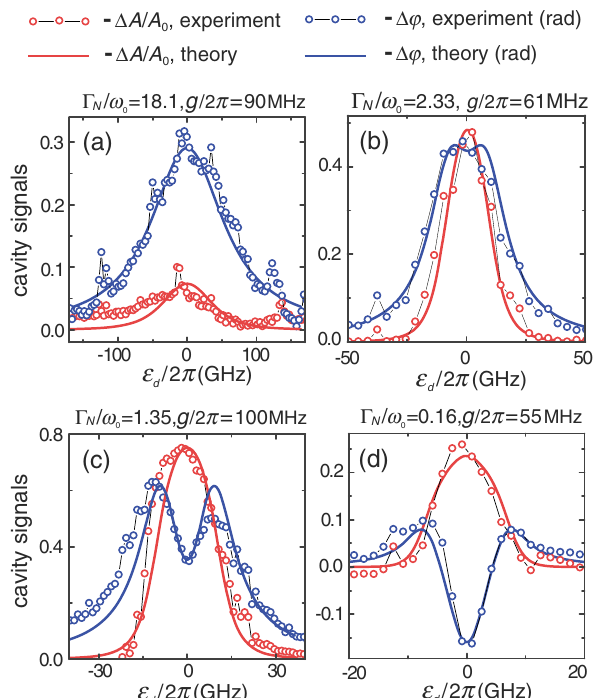
FIG. 2. Panels (a – d): Measured phase shift Δ φ (blue dots) and reduced amplitude shift Δ A=A 0 (red dots) of the microwave signal transmitted by the cavity versus the energy ε 0 and different dot orbitals (for clarity, we have orbital, for V b ¼ plotted the opposite of these signals). The red and blue lines show the predictions given by Eqs. (5) and (6) for values of Γ given in the different panels, and T ¼ 60 mK ≃ 0 . 19 ω 0